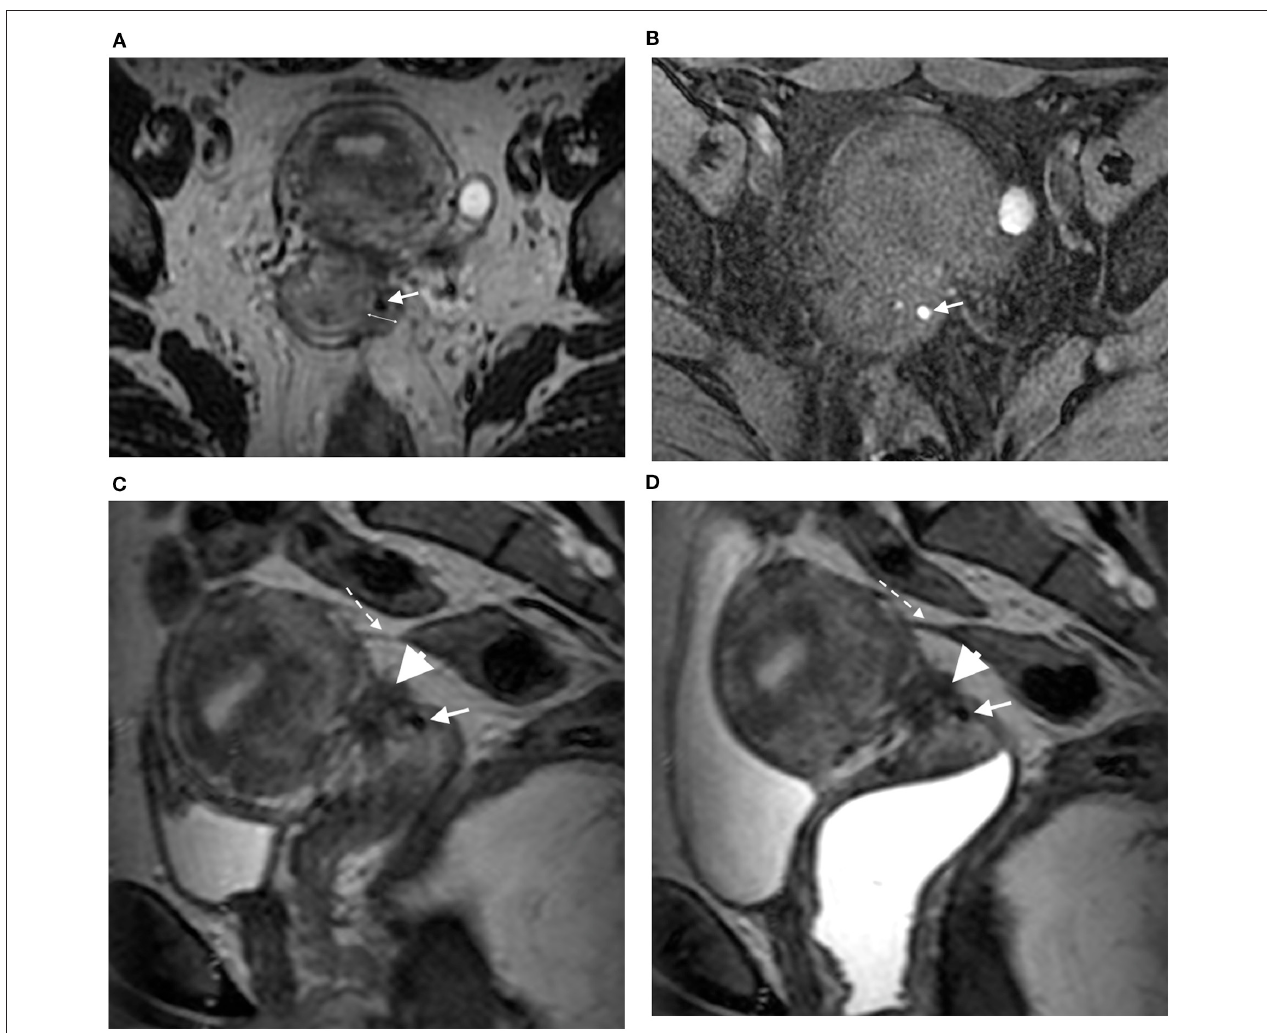
FIGURE 1 | Axial 3DT2 (A) and 3DT1FS (B) MR images in 40-year-old woman show thickening of left lateral vaginal fornix (double arrow) containing spot (arrow) highly suggestive of vaginal endometriosis confirmed on surgery and histopathological examination. Sagittal 3DT2 (C) and 3DT2VO (D) MR images show associated torus uterinum involvement by DE (arrowhead) and rectosigmoid adhesion (dotted arrow). Note the absence of additional information provided by vaginal